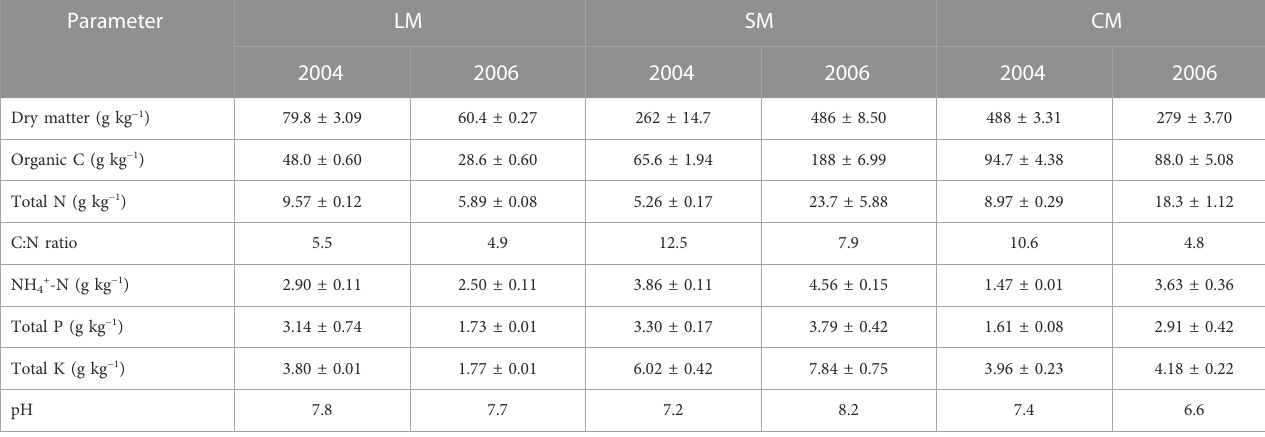
TABLE 3 Chemical and physical compositions of liquid, solid, and composted hog manure applied in the study.